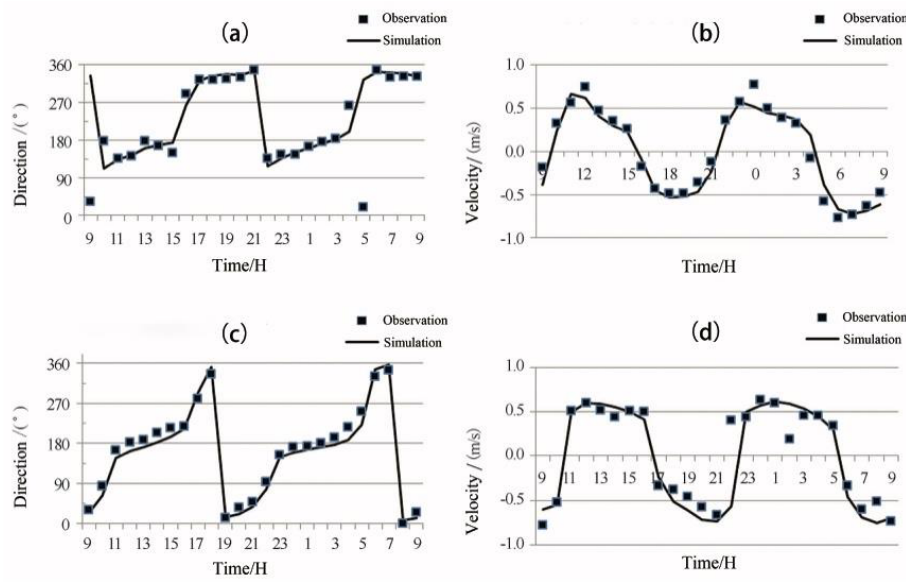
Figure 3. Current velocity and direction during spring tides ( a,c ) stand for direction, ( b , d ) stand for velocity.